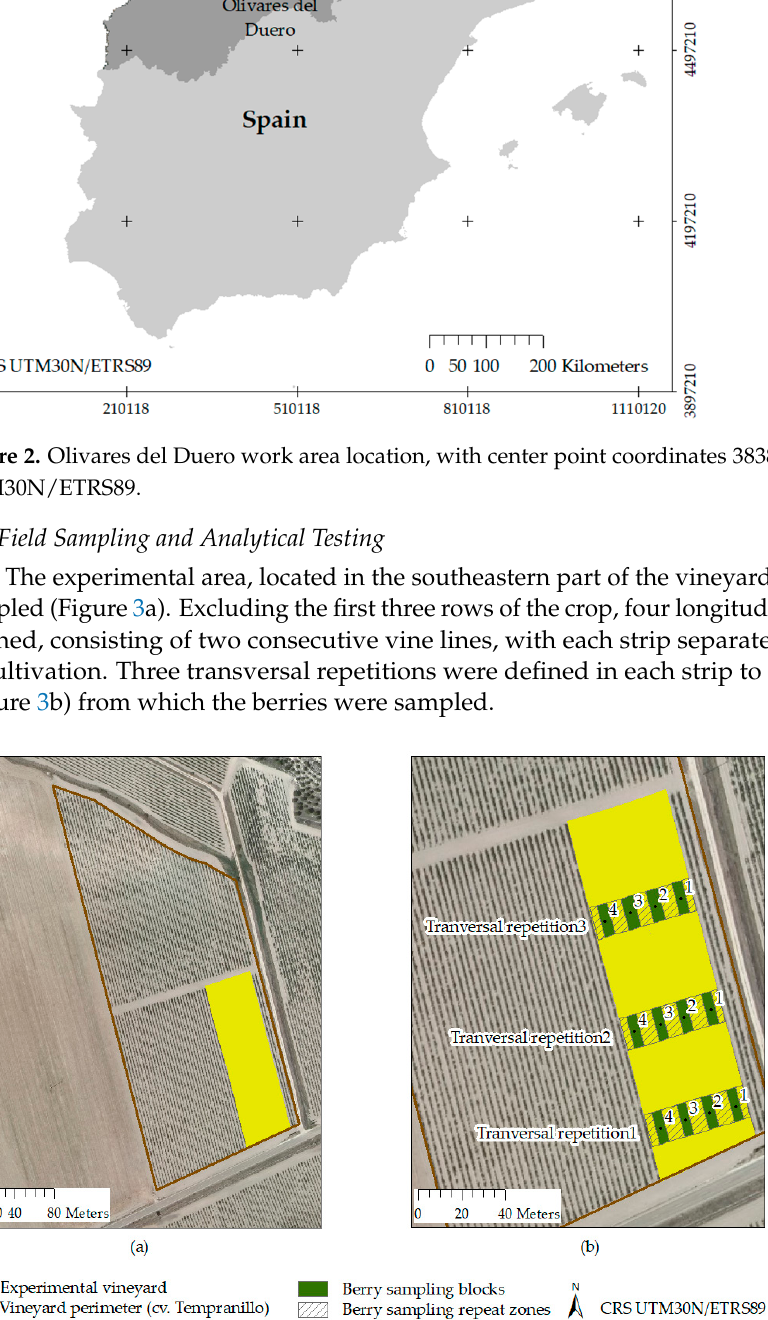
Figure 1. Flowchart illustrating the study methodology.